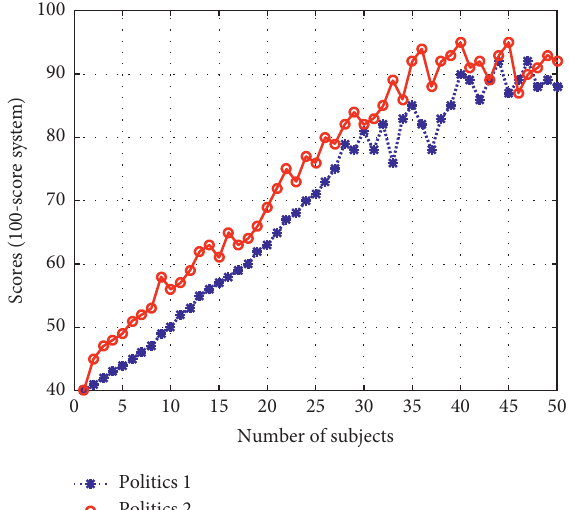
Figure 6: Comparison of political classes before and after the linear mixed model proofreading.